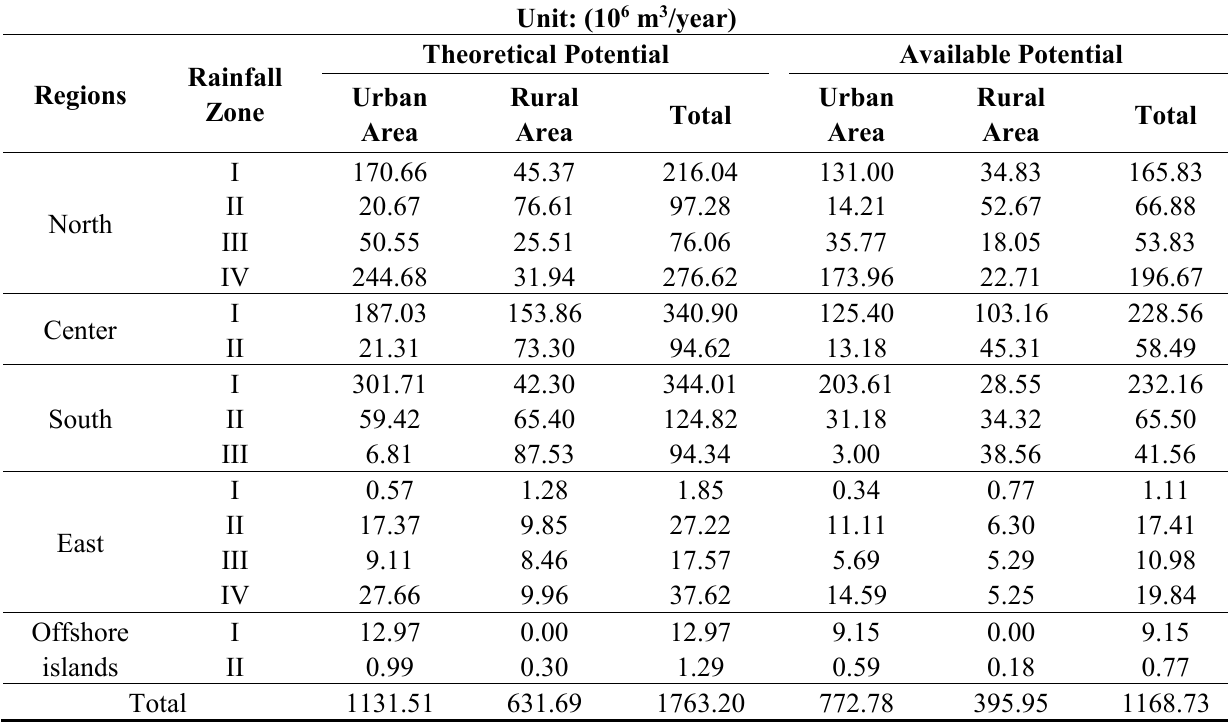
Table 4. Theoretical and available rainwater potential in different regions and rainfall zones.